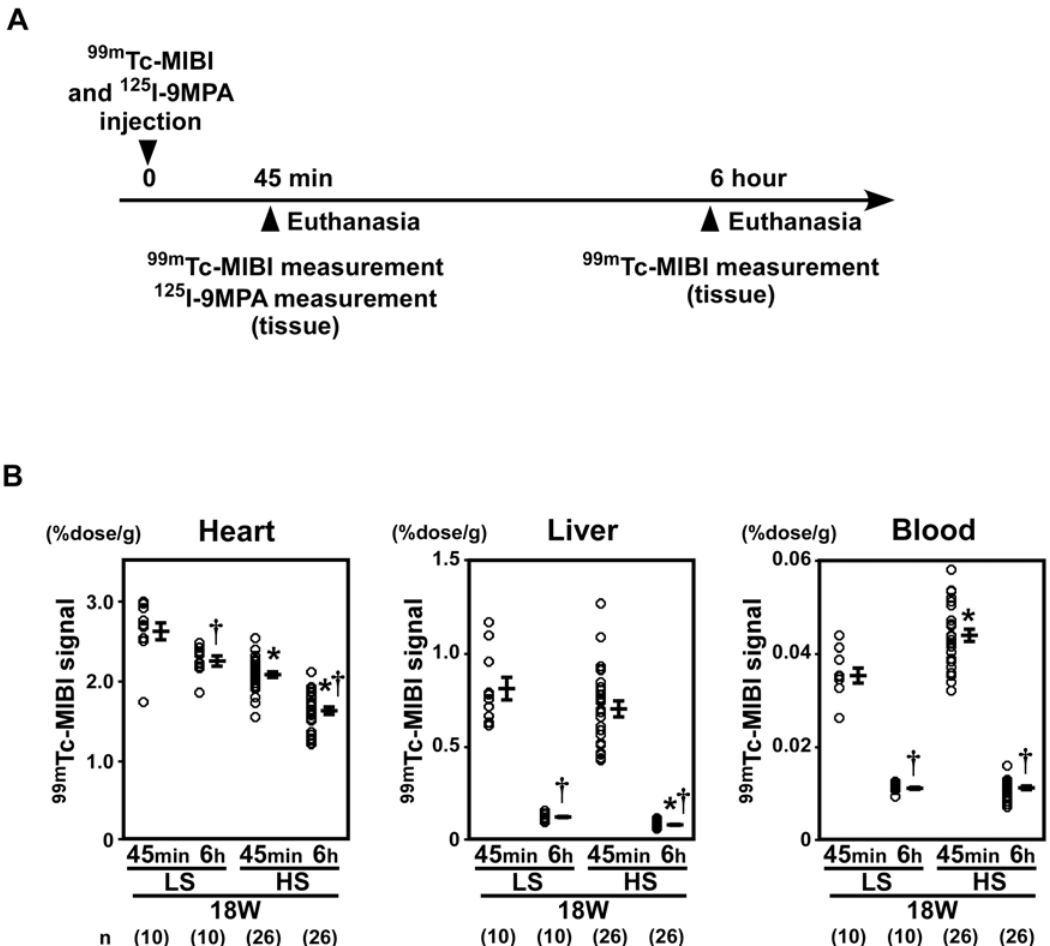
Figure 5. 99m Tc-MIBI signals were decreased in the hearts of DS rats fed a high-salt diet. (A) A schematic representation of the experiments used to analyze 99m Tc-MIBI and 125 I-9MPA signals in DS rats. Analyses of 99m Tc-MIBI and 125 I-9MPA signals in DS rats were performed at 45 min and 6h after injection. (B) At 45 min after injection, the 99m Tc-MIBI signals were lower in DS rats fed an HS diet than those in DS rats fed an LS diet. In the DS rat fed an HS diet and an LS diet, 99m Tc-MIBI signal per heart tissue weight decreased 6 h after the injection compared to 45 min after the injection (left panel) after correction for physical decay. In DS rats fed an HS diet with heart failure at 18 weeks of age, 99m Tc-MIBI signal per heart tissue weight decreased compared to those in control rats fed an LS diet at 6 h after injection. Signals for 99m Tc-MIBI in the liver (middle panel) or blood (right panel) were low in both LS and HS group at 6 h after injection. (LS, 45 min: n = 10, 6 h: n = 10; HS, 45 min: n = 26, 6h: n = 26). LS, low-salt; HS, high-salt. * P < 0.05 versus LS. † P < 0.05 versus the early phase group.